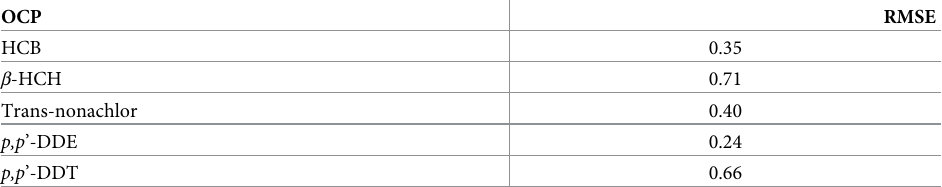
Table 2. RMSE values for BRT models of HCB, β -HCH, Trans-nonachlor, p,p ’-DDE and p,p ’-DDT.